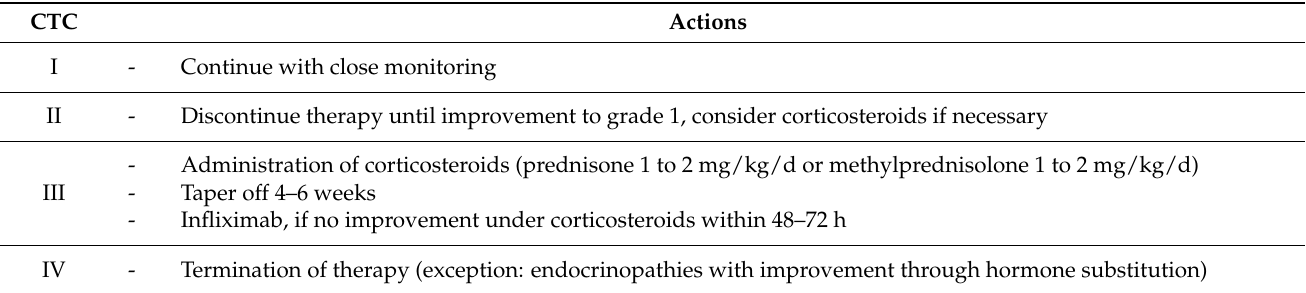
Table 6. Treatment of adverse effects of immune checkpoint